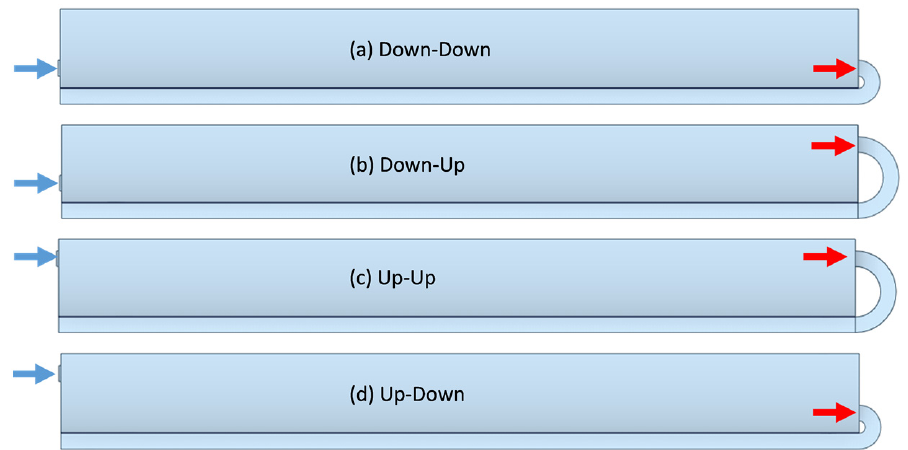
Figure 2. Inlet and outlet studied configurations of U-shape double-pass CPC.